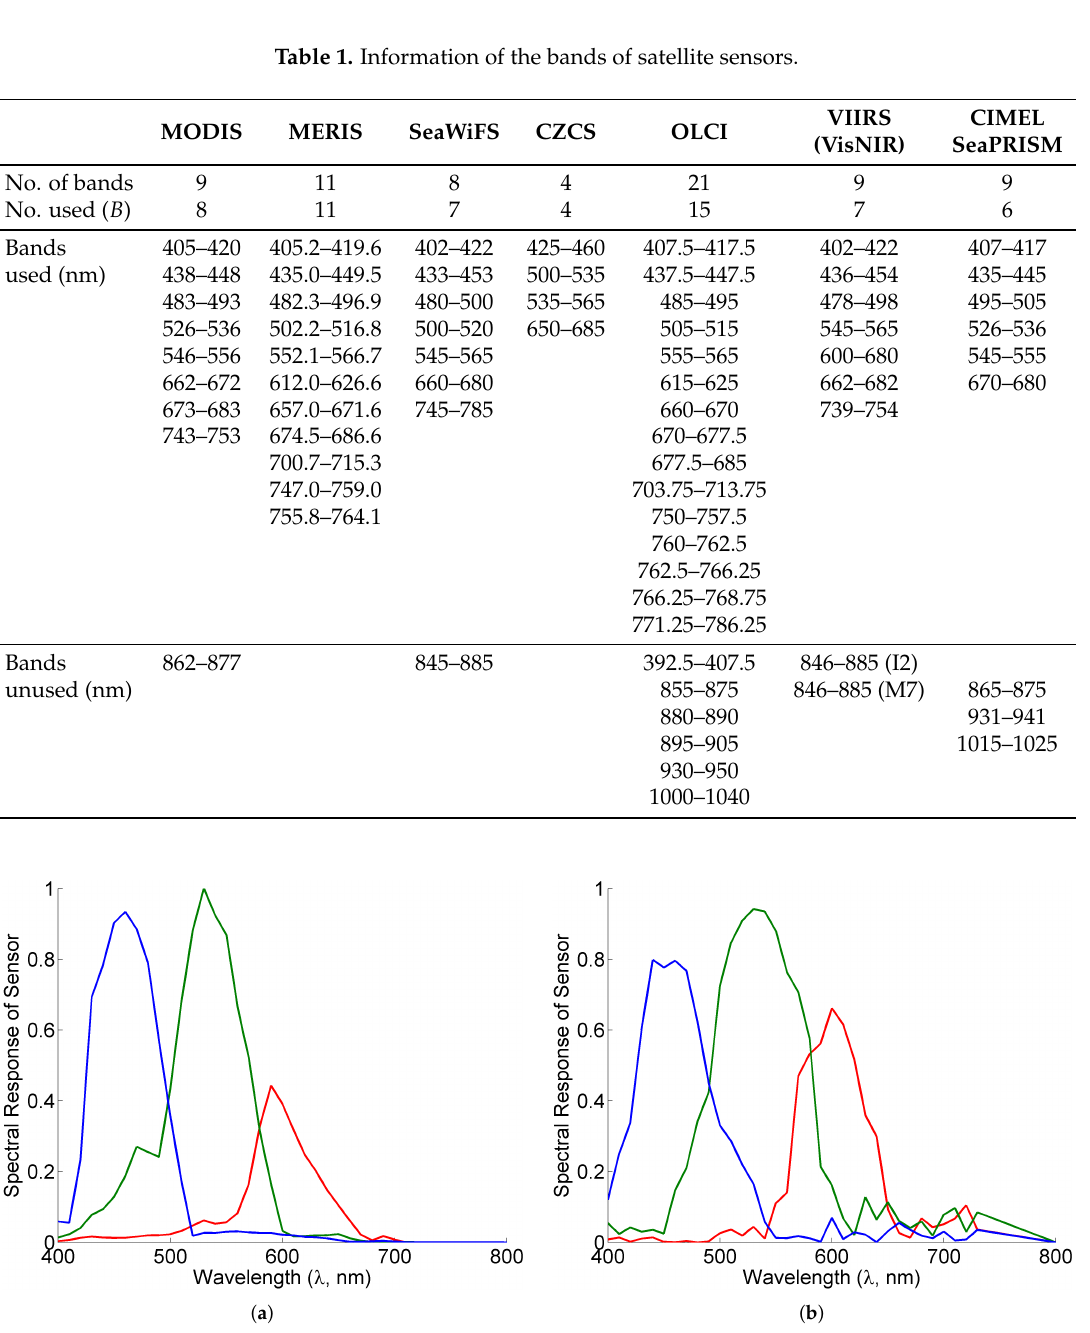
Figure 3. Spectral responses of the various channels of sensors of the consumer camera considered in this paper. ( a ) Canon 1D Mark III; ( b ) Nikon